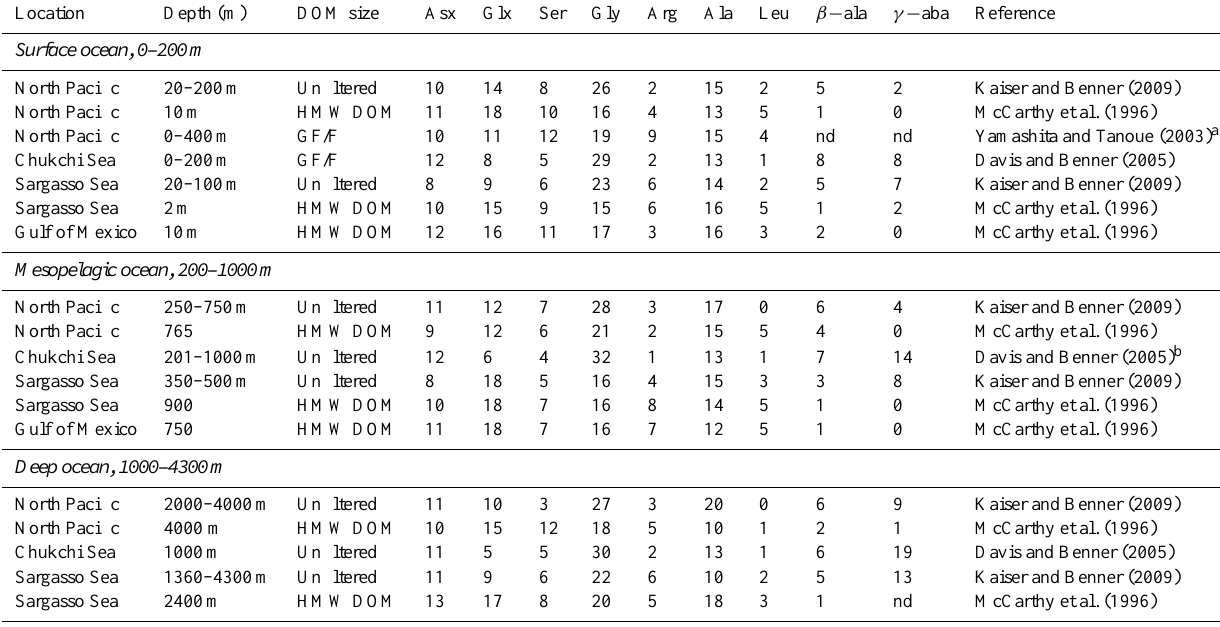
Table 4. Molecular composition (mol%) of amino acids found on the ocean surface and in mesopelagic and deep layers. HMW DOM: 1nm to 0.2µm; GF/F DOM: ∼ 0.7µm. nd: no